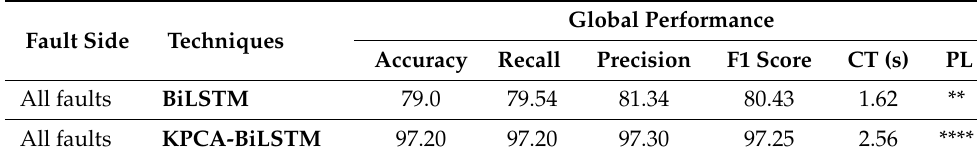
Table 8. Performance comparison of different techniques.